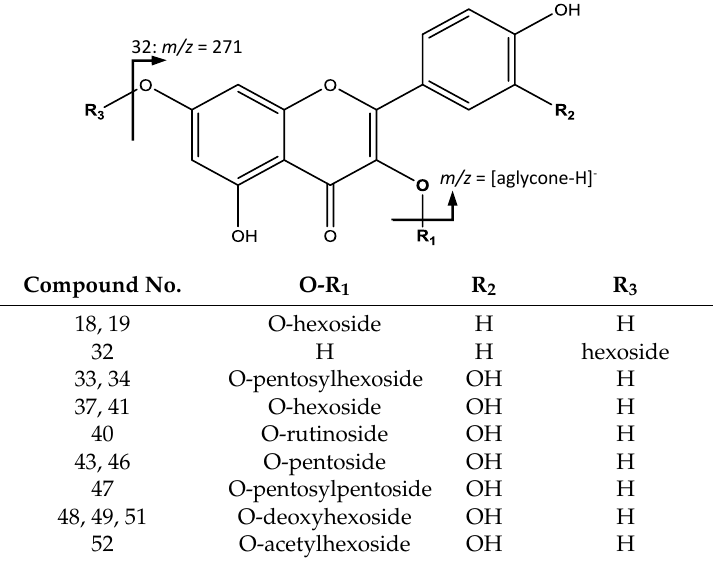
Figure 6. Flavonol glycosides structure and main fragments.